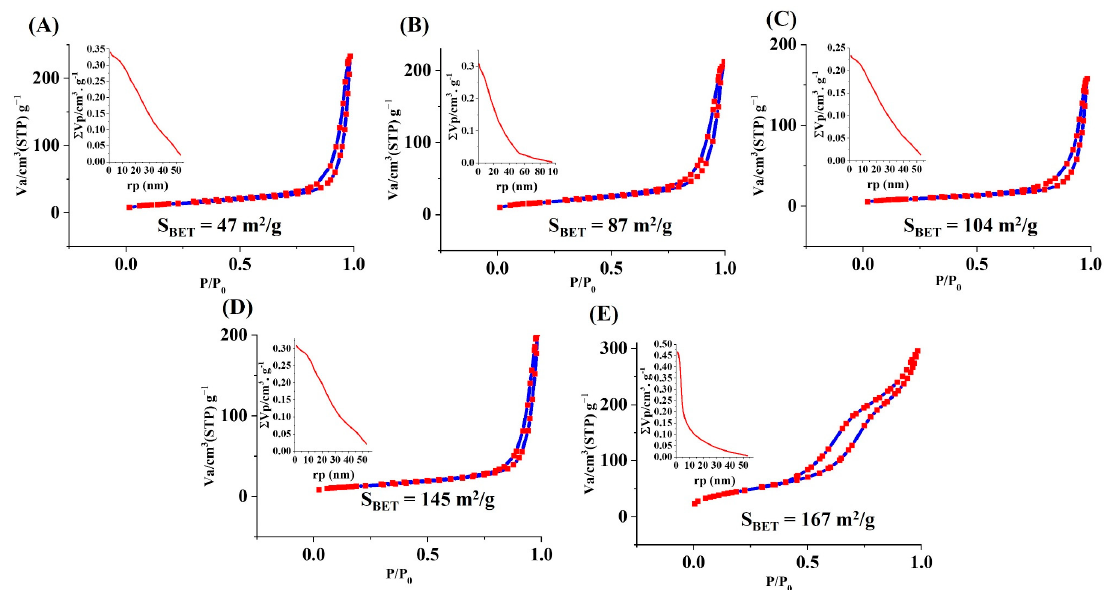
Figure 9. N 2 adsorption/desorption graphs of ( A ) the un-doped and ( B – E ) 1, 2.5, 5, and 7.5 mol% Ag-doped